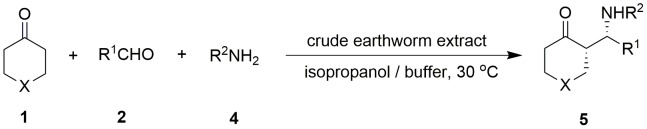
The crude earthworm extract catalysed direct asymmetric Mannich reactions.